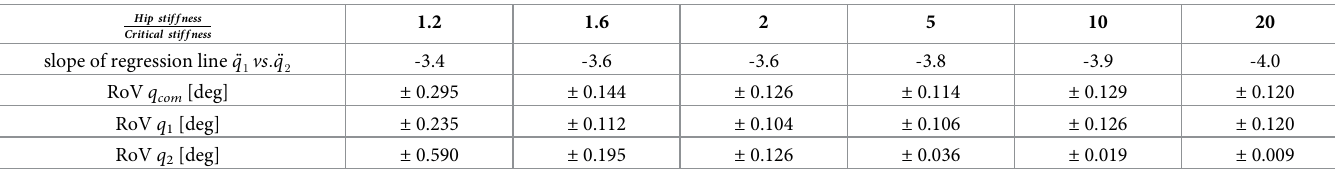
Table 5. Influence of the hip